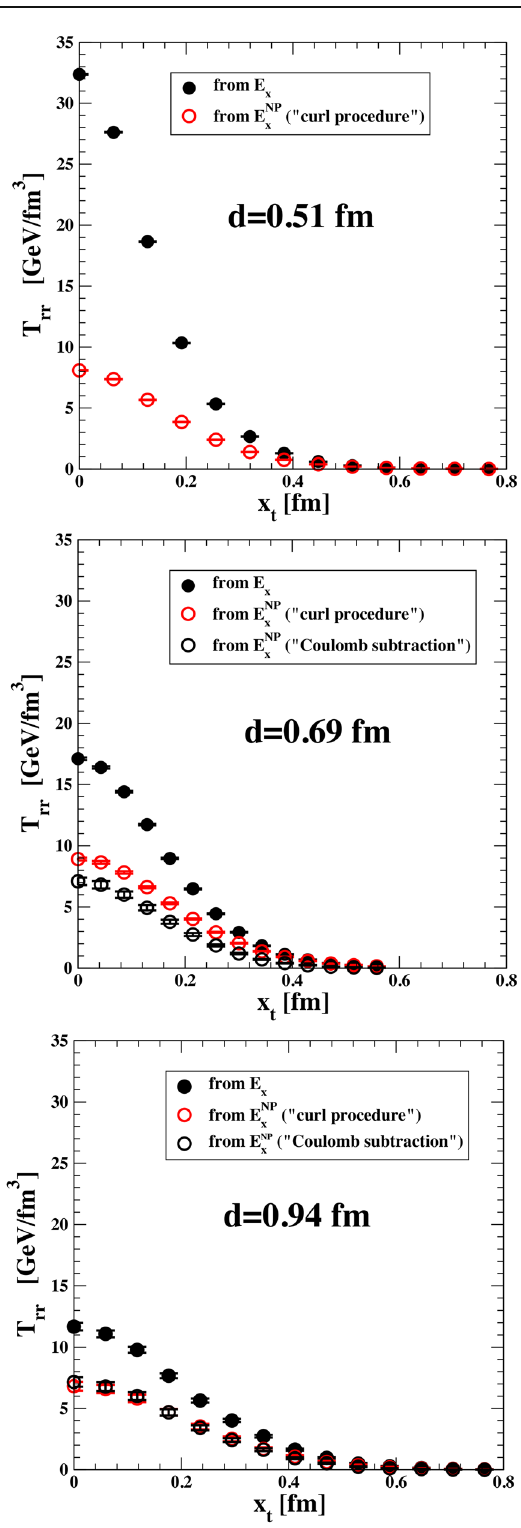
Fig. 11 The diagonal components of the Maxwell stress tensor recov- ered from the full field E x (filled circles) and non-perturbative field E ( NP ) x (empty circles) for d = 0 . 51 fm (top), d = 0 . 69 fm (middle), and d = 0 . 95 fm